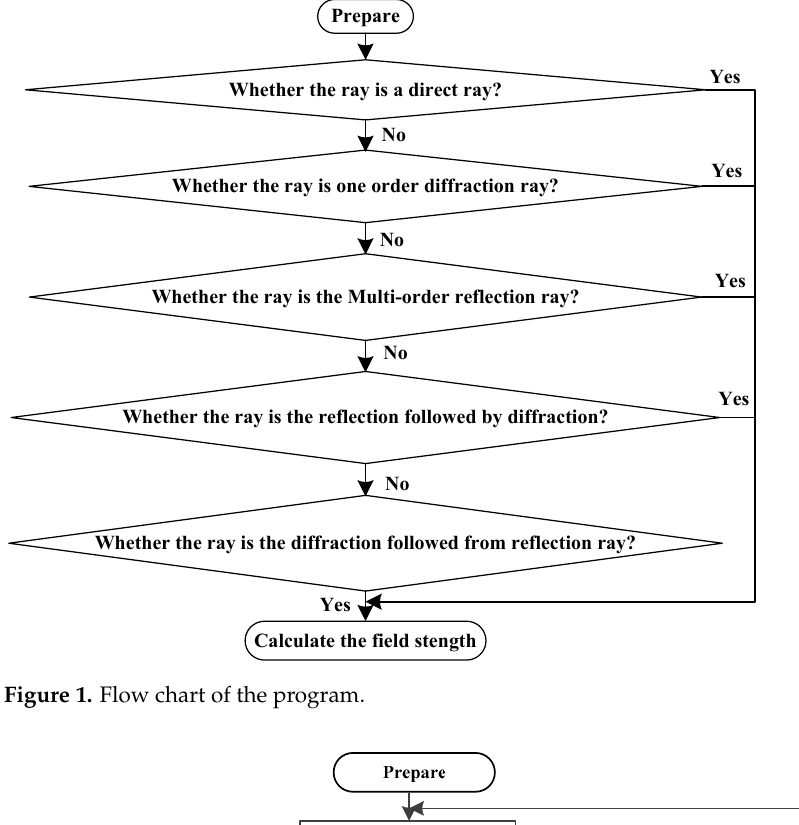
Figure 1. Flow chart of the program.